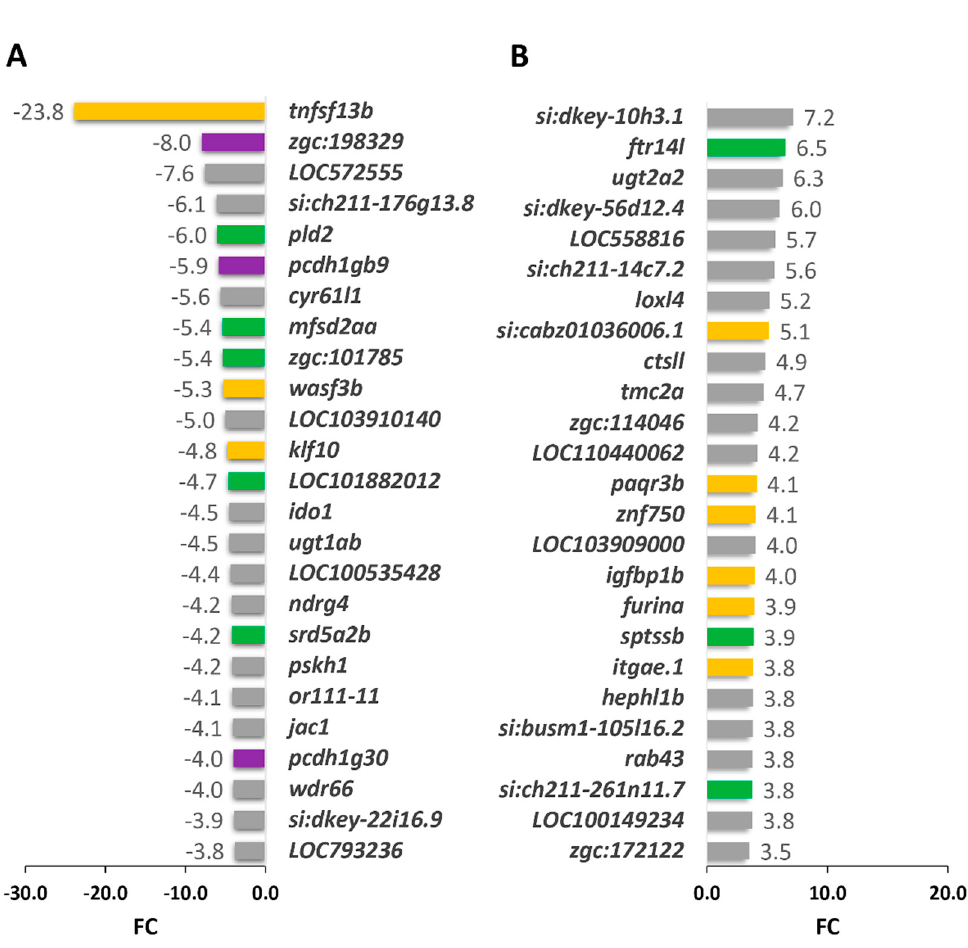
Figure 7. Top 25 DEGS in cyp1b1 -KO vs. wildtype seven-dpf zebrafish larvae. ( A ) Down- and ( B ) upregulated genes identified by high-throughput RNA sequencing with significant differences in the comparison. Yellow bars: development signaling genes. Green bars: lipid metabolism genes. Purple bars: extracellular matrix and cell adhesion genes. Grey: down- and upregulated genes from other functional pathways.